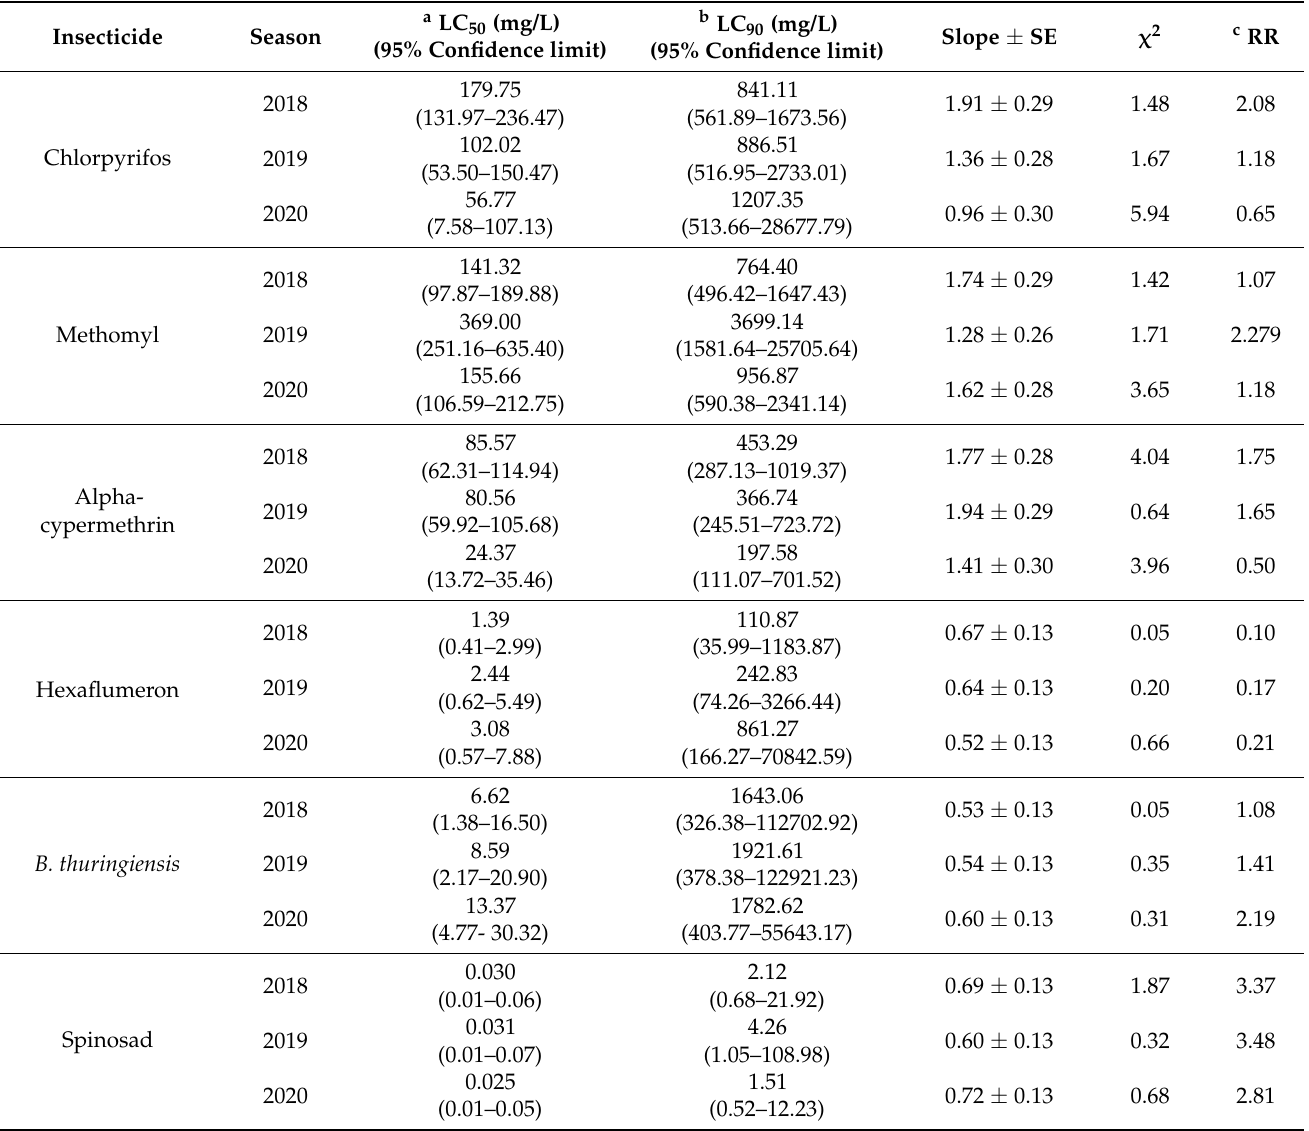
Table 5. Susceptibility of the fourth instar larvae of Kafr El-Shiekh field strain of Spodoptera littoralis to six insecticides over three consecutive seasons (2018 to 2020). Egg masses of S. littoralis , collected over three consecutive seasons (2018 to 2020), were kept in the rearing room until the fourth instar larvae. Six concentrations of each tested insecticide were prepared, then castor bean leaves were immersed in each concentration for 20 s. For each concentration, 50 larvae were used to calculate the LC 50 , LC 90 and the resistance